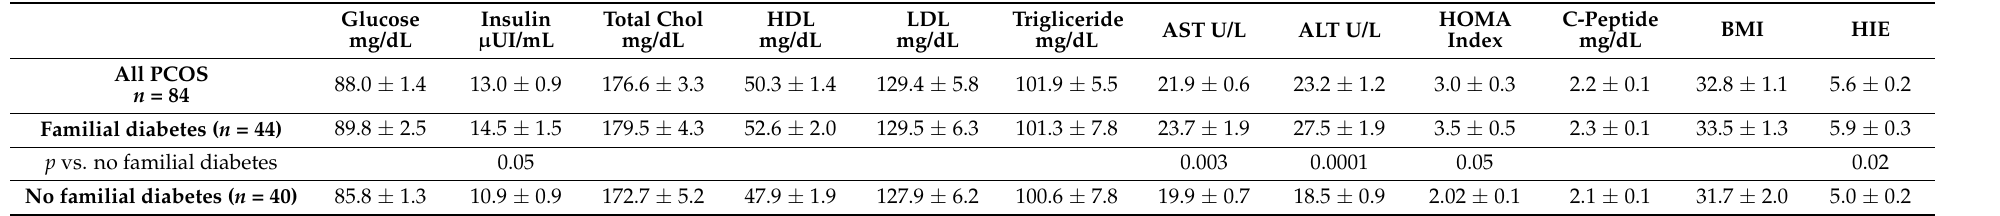
Table 1. Metabolic parameters of women with PCOS and overweight/obesity selected for the study ( n = 84).